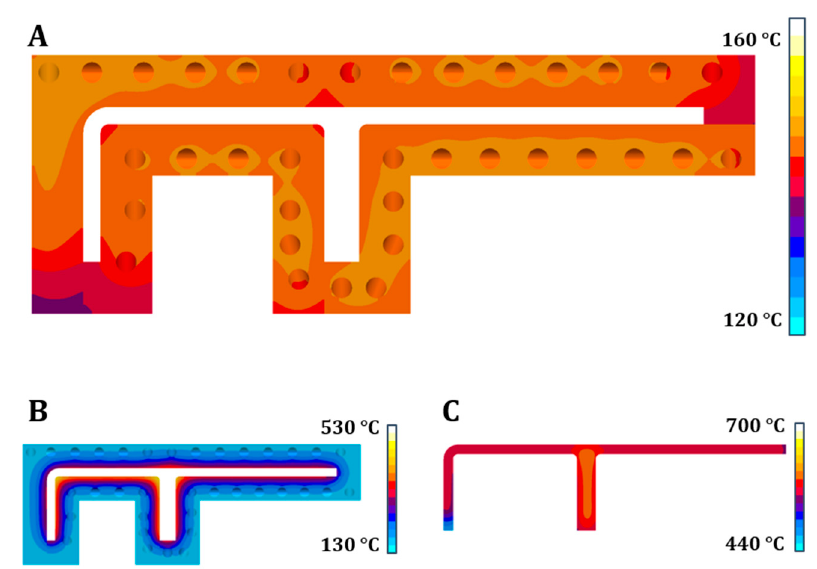
Figure 7. On top ( A ) the heat distribution in the mold after 45 min of temperature control set to 150 °C. The calculated heat distribution in the middle plane when 50% off the material has solidified after 13 s are shown for the mold at the bottom left ( B ) and for the casting at the bottom right ( C ).